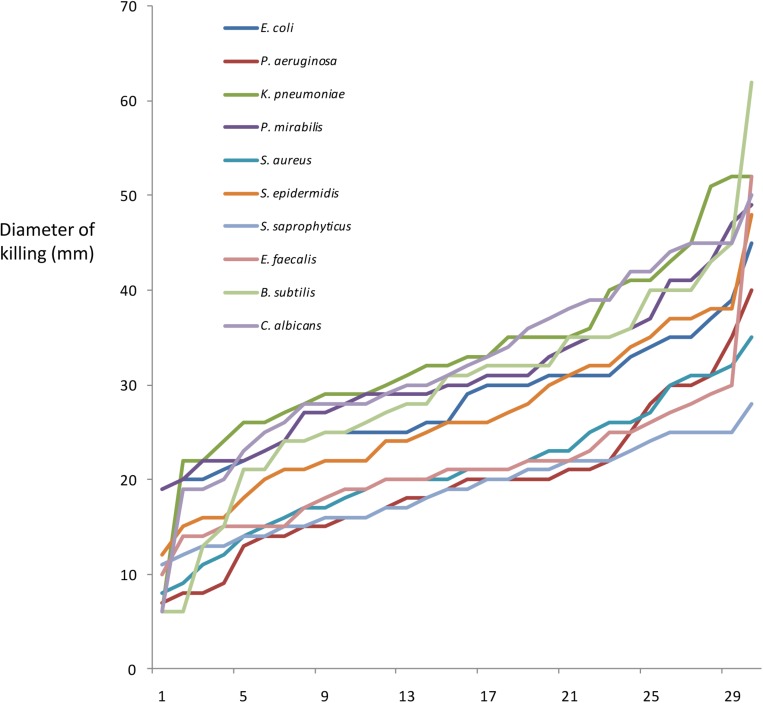
Predation efficiency (mm diameter of predation zone after 7 days), of 29 predatory strains, when preying upon 10 prey organisms. For each prey organism, strains are arranged in order of increasing predation efficiency.